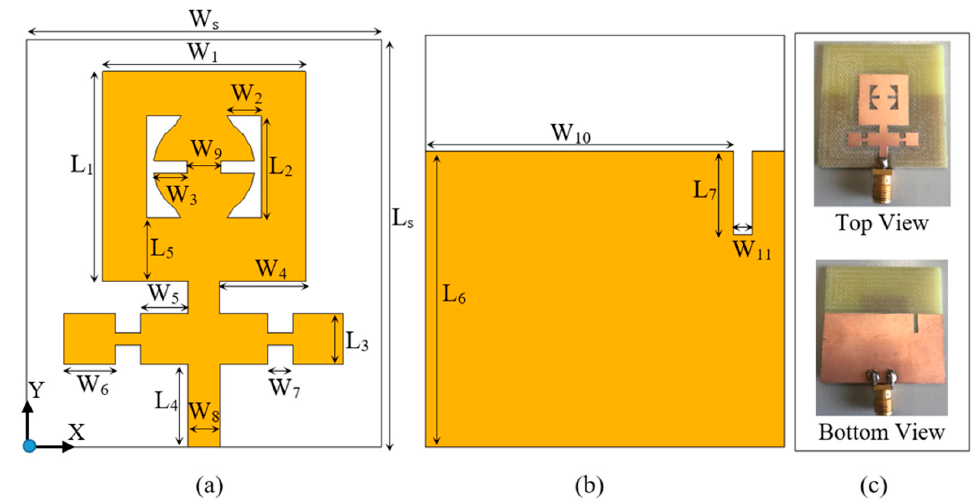
Figure 2. Geometry of the proposed filtering antenna with its optimized dimensions: ( a ) Top view ( b ) Bottom view ( c ) Photograph of the hardware realization. Table 1. The optimized dimensions of the proposed filtering antenna (in mm).